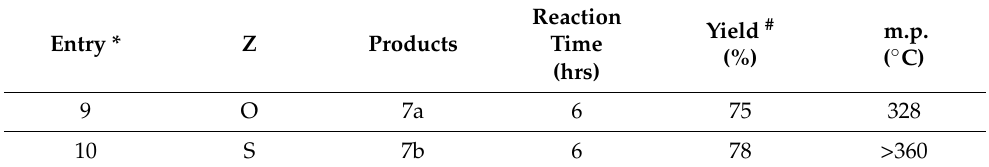
Table 3. Synthesis of Spiro fused heterotricyclic compounds.